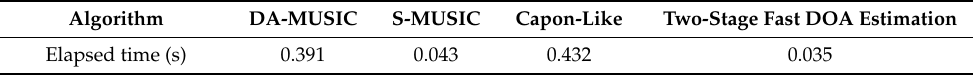
Table 5. Elapsed time for four algorithms.